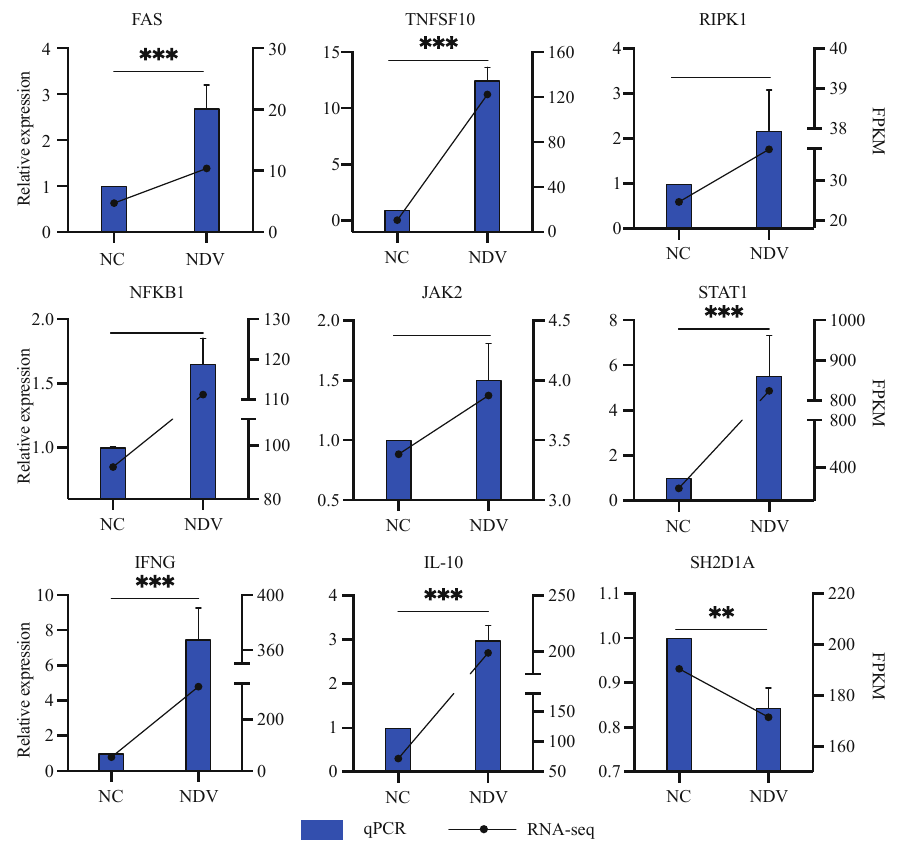
Figure 5. qPCR validation ( n = 3). ** and *** indicate significant differences at q < 0.01 and q < 0.001, respectively.